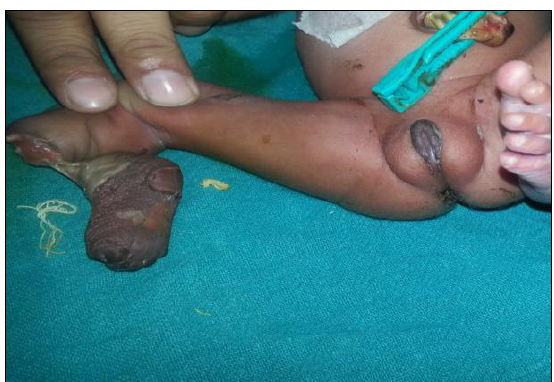
Figure 1: Devitalized amputated part of lower